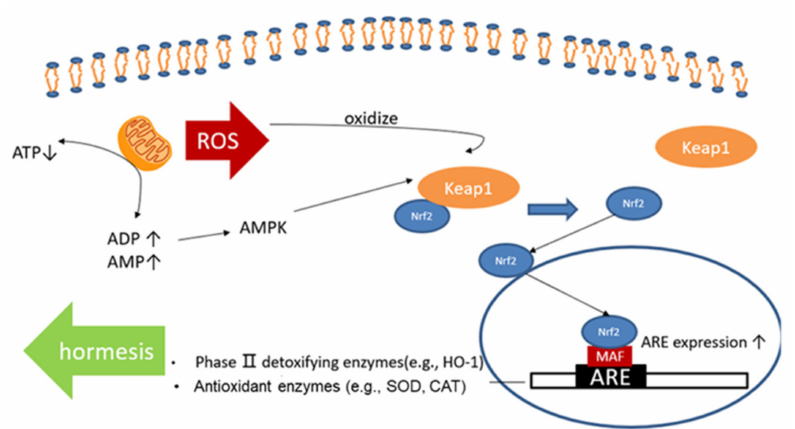
Figure 1. Nrf2 signaling. Nrf2 is activated by ROS. ROS, reactive oxygen species; Keap1, Kelch-like ECH-associated protein 1; Nrf2, nuclear factor erythroid 2-related factor; HO-1, hemeoxygenase-1; MAF, musculoaponeurotic fibrosarcoma; ARE, antioxidant response element; HO-1, hemeoxygenase- 1; SOD, superoxide dismutase; CAT,